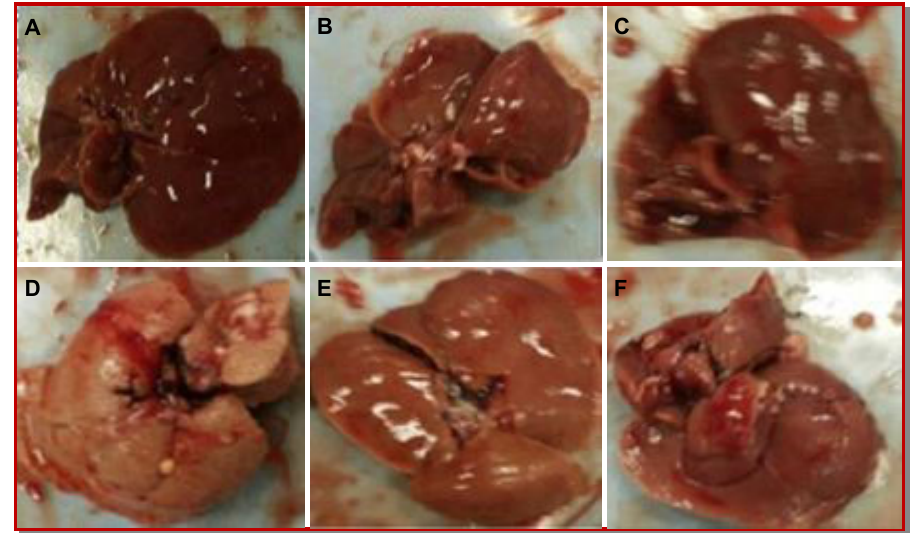
Figure 4 : Gross appearance of livers. Excised livers from the treated animals after dissection and photographed. Representative of n=5 from each group. A: Corn oil treatment, B: Corn oil + leaf extract (500 mg/kg), C: Corn oil + rhizome extract (500 mg/kg) D: CCL 4 treated, E: CCL 4 + leaf extract 500 mg/kg, F: Corn oil+ rhizome extract 500